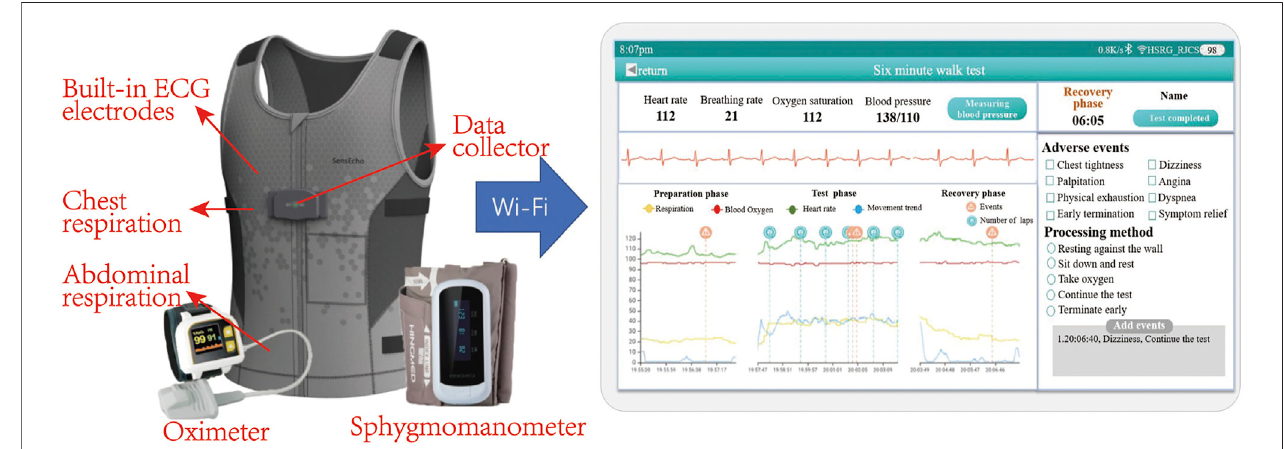
FIGURE1| Pictureofmulti-functional6MWTsystem,includingwearabledevicesandanintelligenceterminaldevice(ahand-heldPAD).Wearabledevicesincludea fl exible vest, an oximeter and a blood pressure monitor. The system is able to monitor ECG, respiratory waves, triaxial acceleration, oxygen saturation and blood pressure. The physiological signal can be transmitted to the PAD via Wi-Fi and displayed in real time.